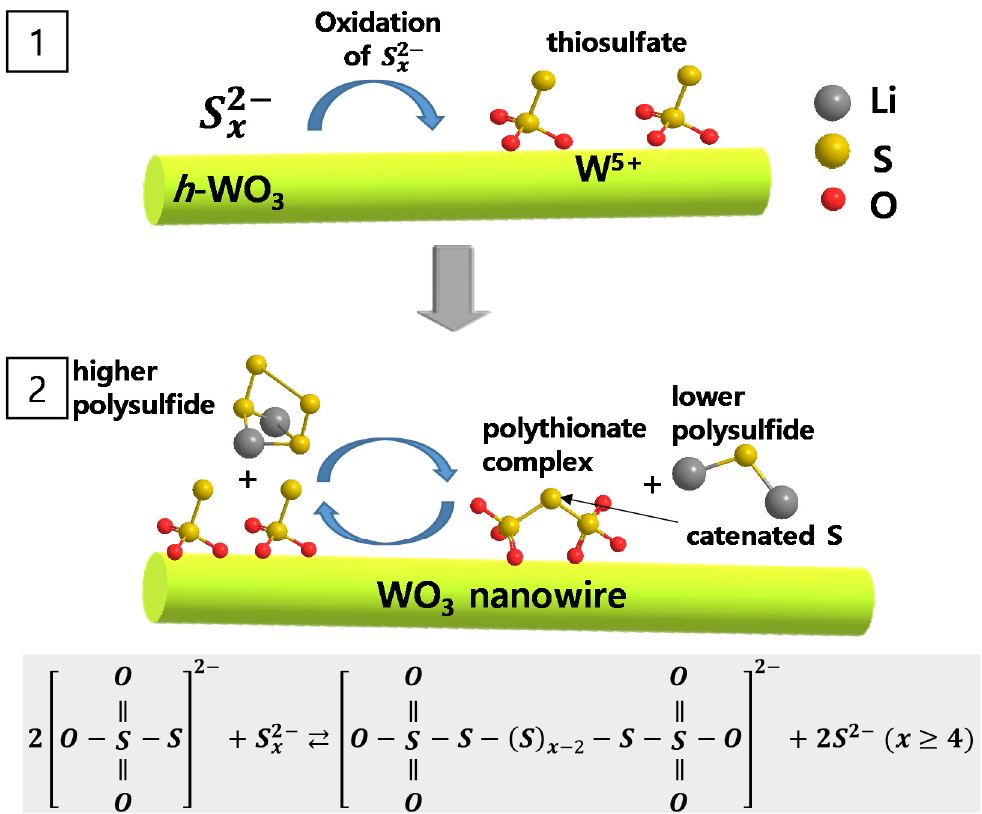
Figure 3. Schematic of lithium polysulfide conversion catalyzed on WO 3 nanowire. Molecules 2021 , 26 , x FOR PEER REVIEW